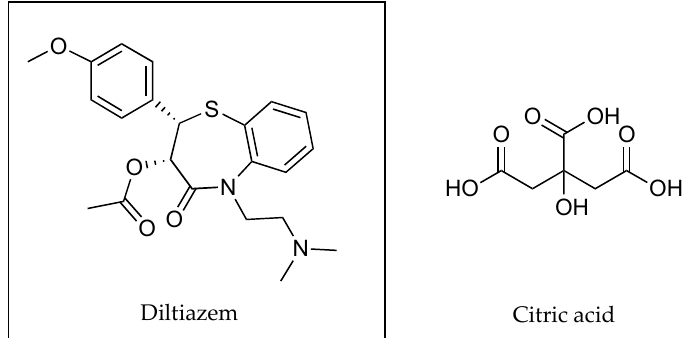
Figure 15. Diltiazem and citric acid counter ion.